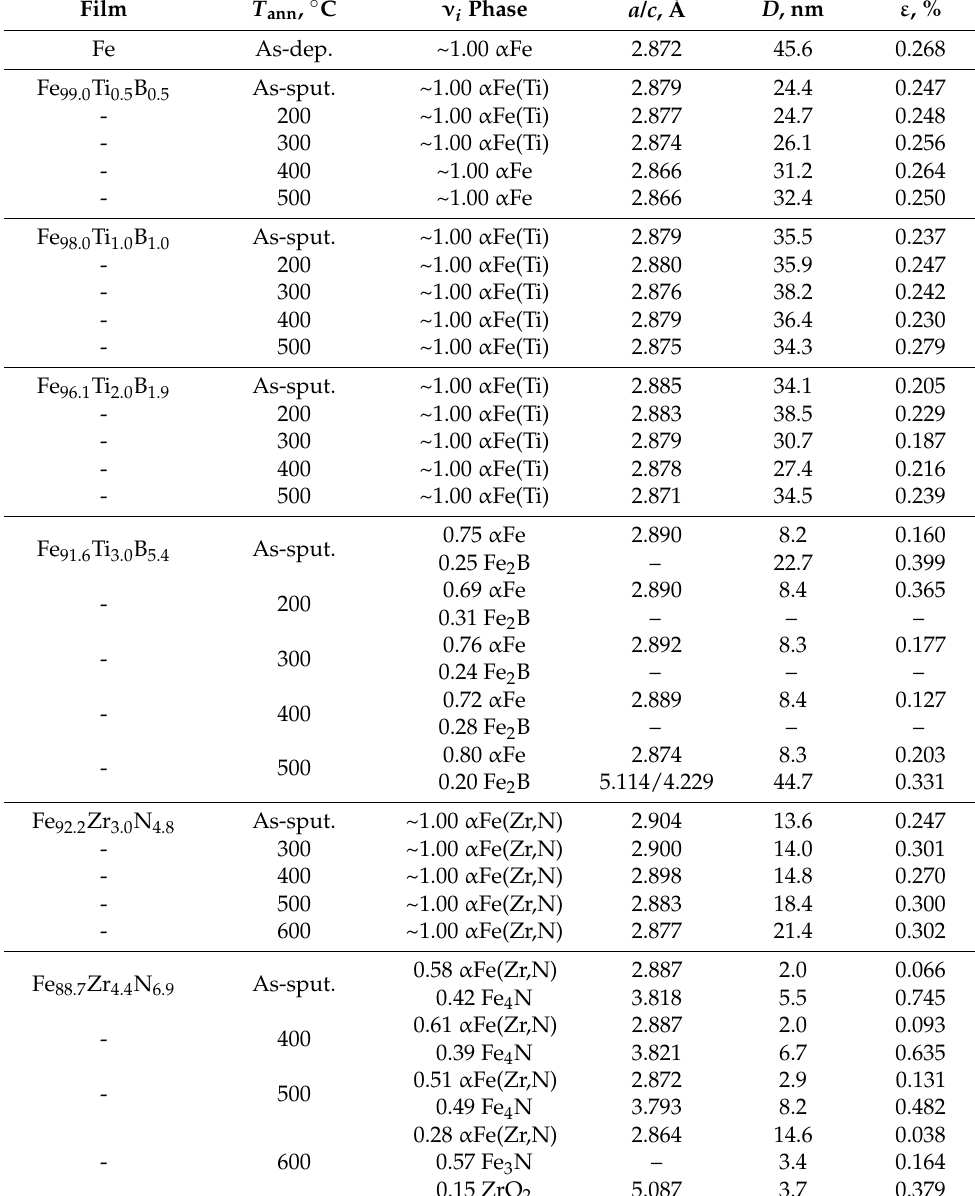
Table 1. Phase composition and structure of the studied films in as-deposited and annealed